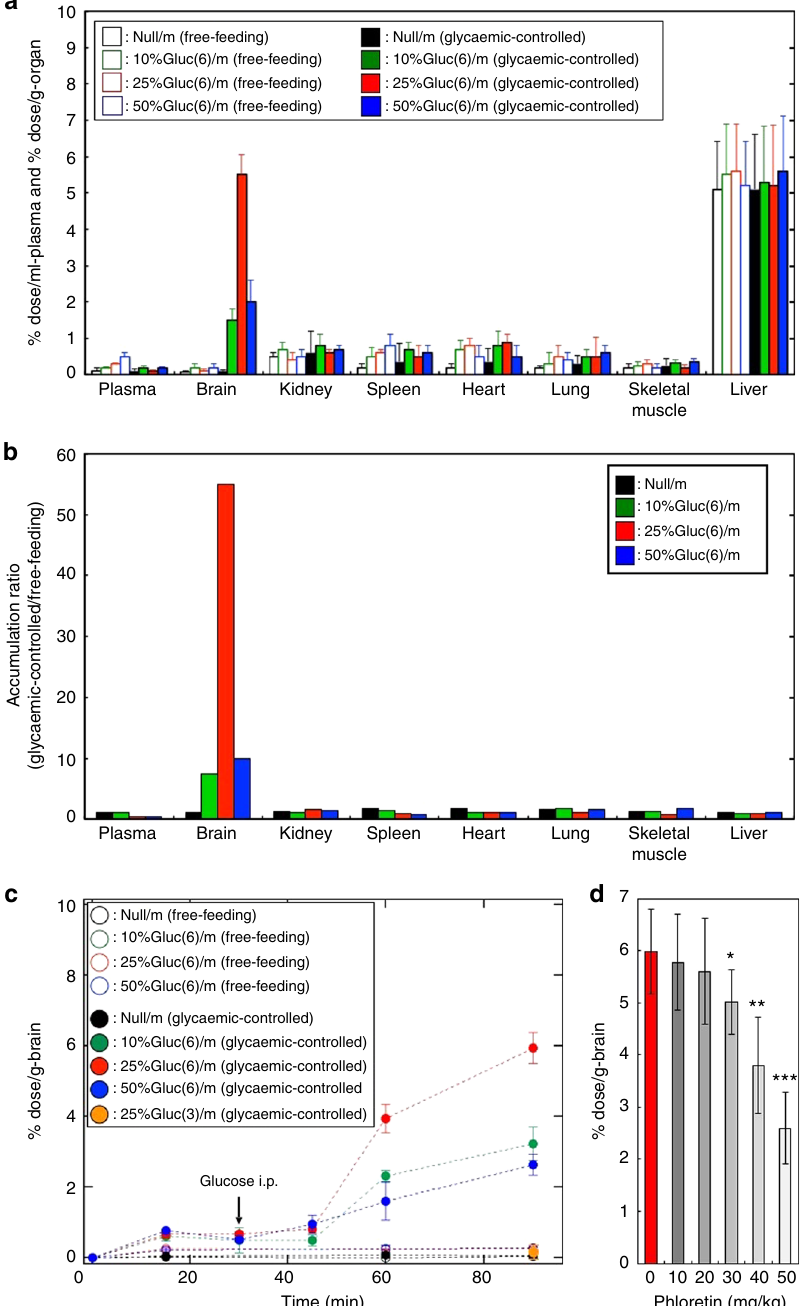
Fig. 2 Pharmacokinetic pro fi les of the polymeric micelles. a Biodistribution of micelles (Null/m and Gluc(6)/m) in mice under different feeding conditions at 48 h after the injection. Open and closed bars show free-feeding and glycaemic-controlled groups, respectively. Black, green, red and blue coloured bars indicate Null/m, 10%Gluc(6)/m, 25%Gluc(6)/m and 50%Gluc(6)/m, respectively. b Accumulation ratio in mice (glycaemic-controlled/free-feeding) of each micelle at 48 h calculated from the values shown in a . c Time course of micelle accumulation (Null/m, Gluc(6)/m and Gluc(3)/m) in the mouse brain under different feeding conditions. The arrow in c indicates when 20 wt% glucose was intraperitoneally injected. Open and closed circles denote the free- feeding and glycaemic-controlled groups, respectively. Black, green, red and blue coloured circles indicate Null/m, 10%Gluc(6)/m, 25%Gluc(6)/m and 50%Gluc(6)/m, respectively. An orange coloured circle shows 25%Gluc(3)/m (glycaemic-controlled). d In vivo inhibition study of the brain accumulation of the 25%Gluc(6)/m by phloretin. Red and grey bars show experiments conducted without and with phloretin, respectively. Experiments were performed using BALB/c mice (female, 6-week-old, n = 5). The data are expressed as the mean ± SEM for a , c , d and as the mean for b . * P <